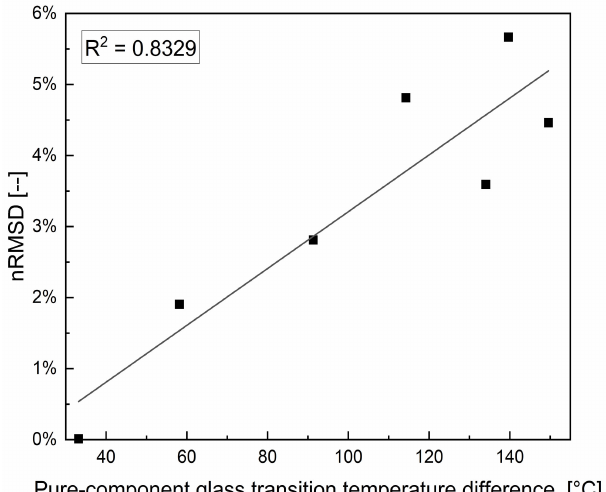
Figure 6. The normalized root-mean-square deviation ( nRMSD ) as a scale-independent measure of the deviation plotted against the difference of pure-component glass transition temperatures ∆ T g of the investigated binary